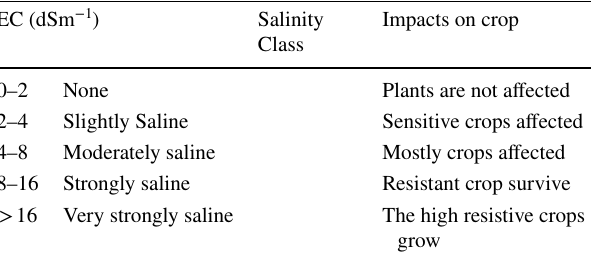
Table 2 EC-based Soil classification (undefined FAO and FAO-Food and Agriculture Organization of the United Nations